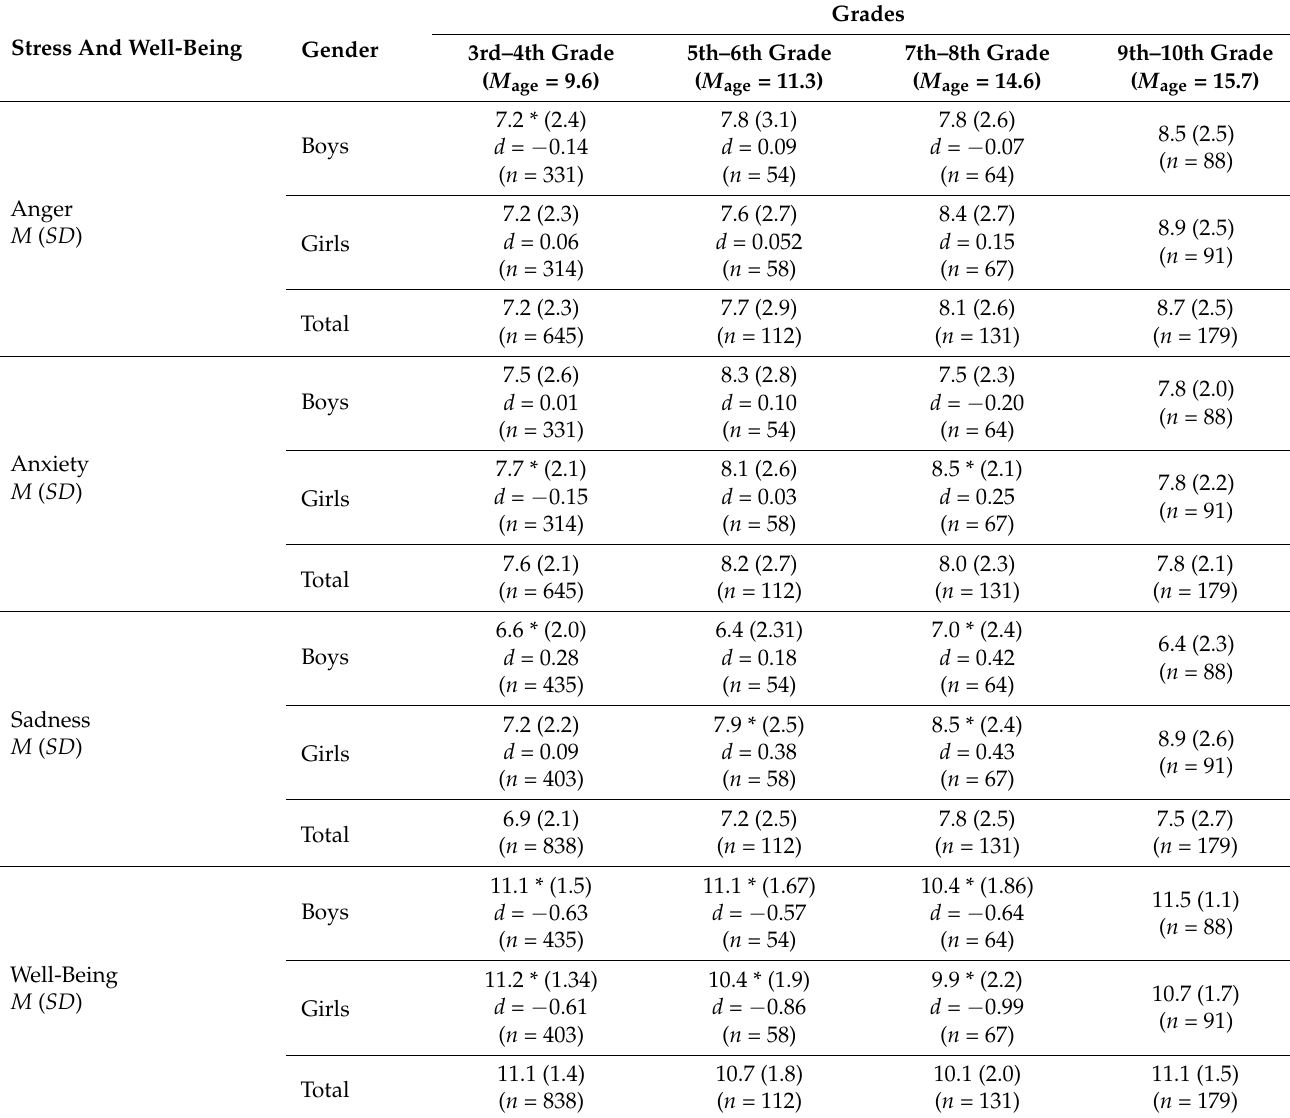
Table 4. Comparisons of stress and well-being scores with norm values [45] as a function of gender and grades of